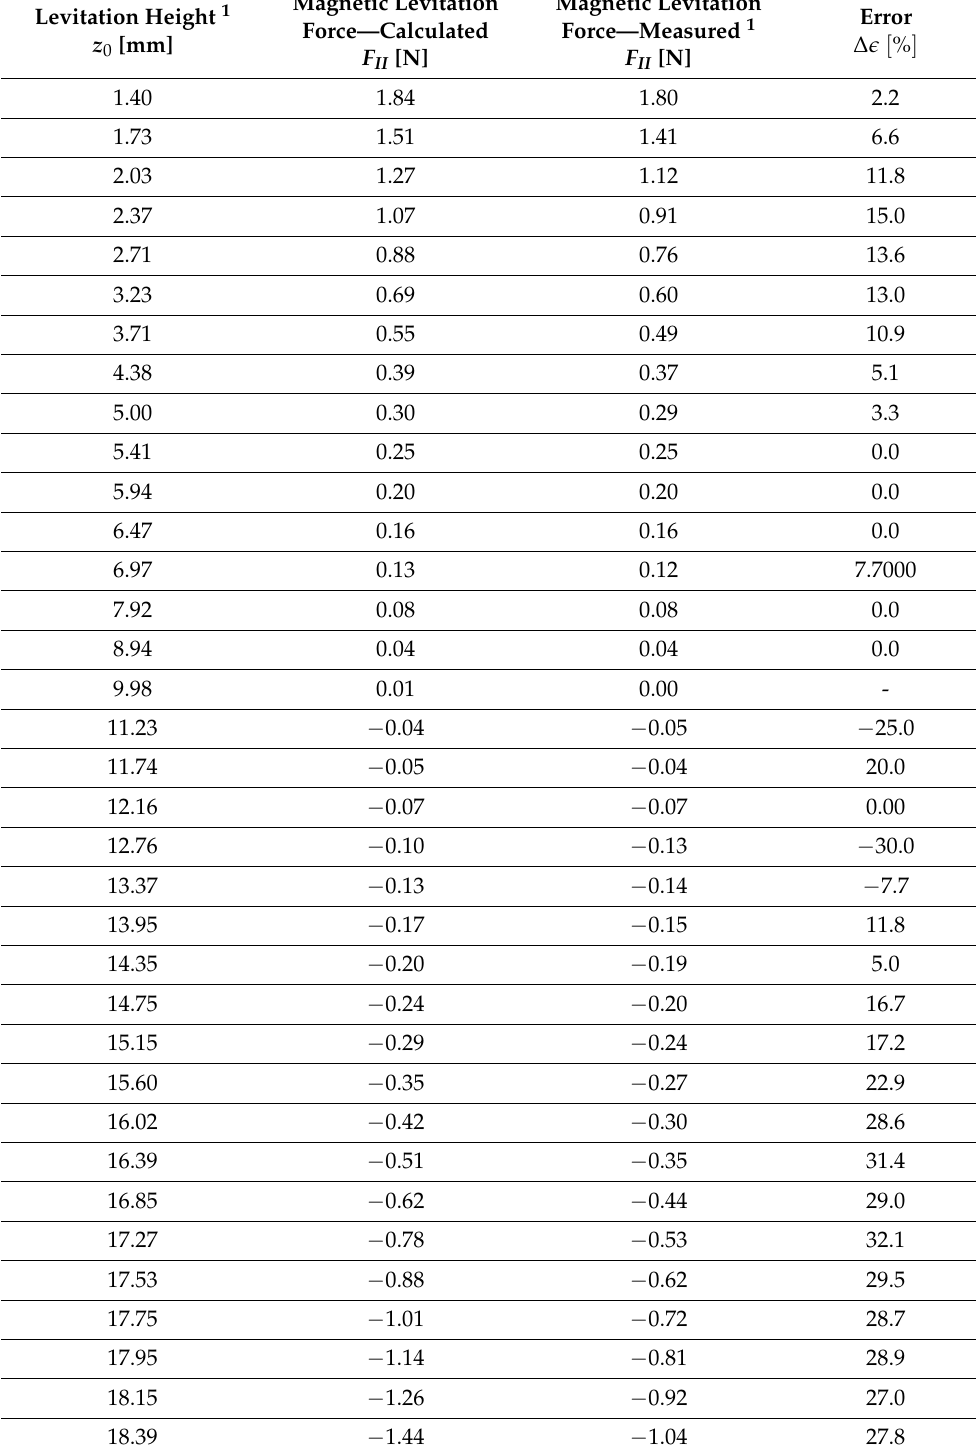
Table 2. Numerical values pertain to calculated and measured values of magnetic levitation force. The error analysis is given for the difference between the calculated and measured